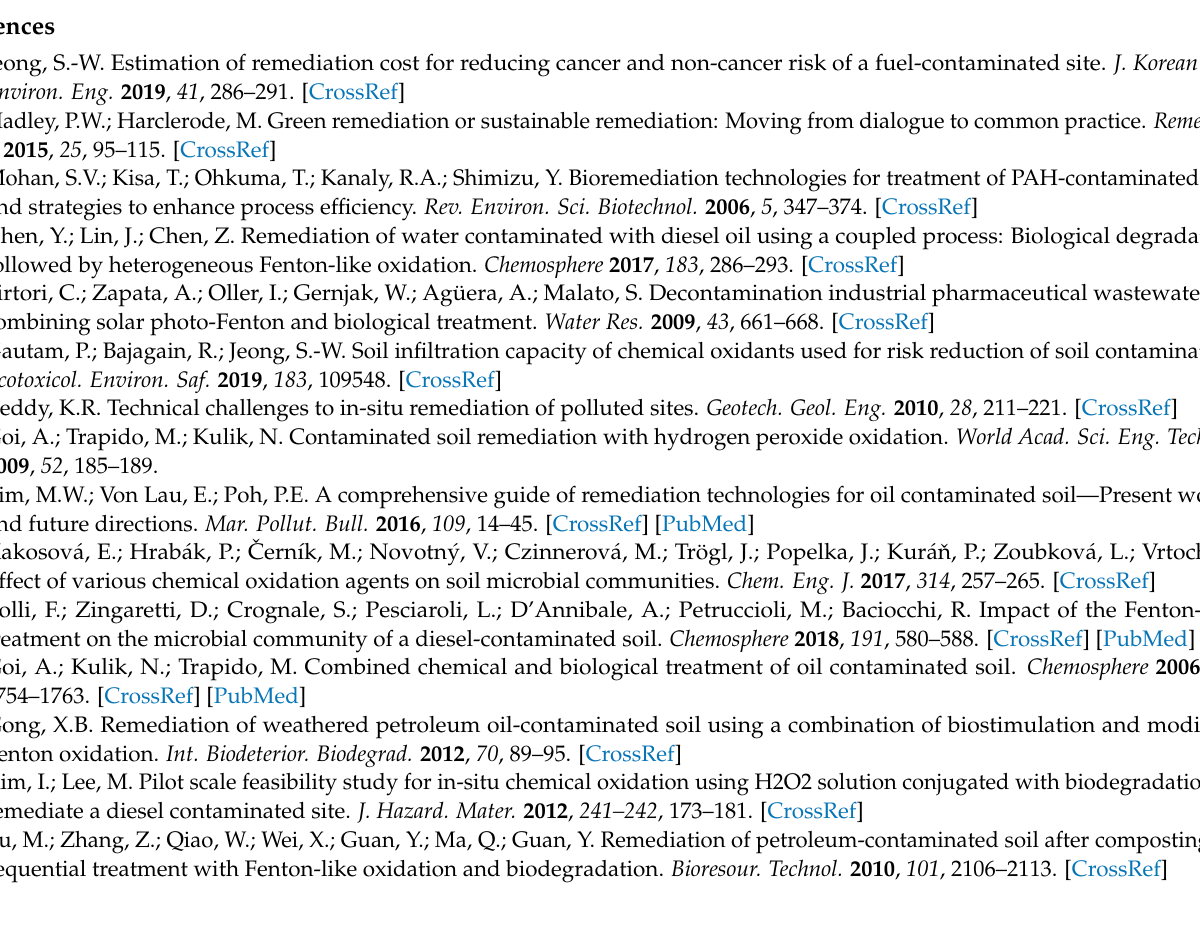
Figure S5: Surfactant foam bubbles at different nodal angles and plateau border lengths for (a) pure AOS, (b) pre-oxidation, and (c) bio-augmentation. Table S1: Physicochemical properties of experimental soil. Table S2: Properties of the different surfactant foams applied in this study. Table S3: Change in microbial population (CFU/g) of soil during remediation. Table S4: Change in pH of soil during remediation. Text S1: Foam